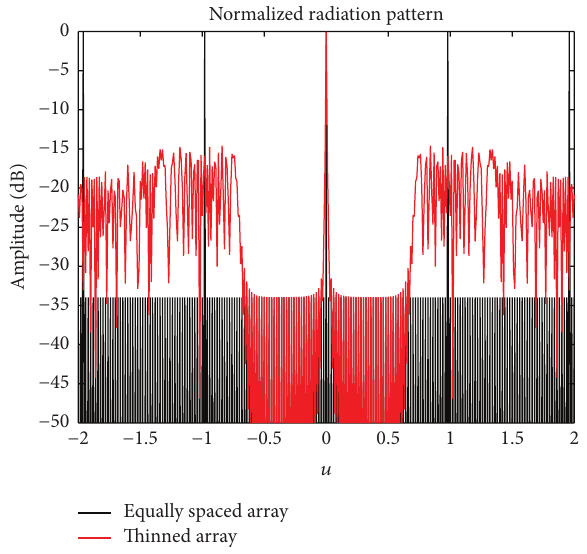
Figure 1: Radiation pattern of equally spaced and thinned